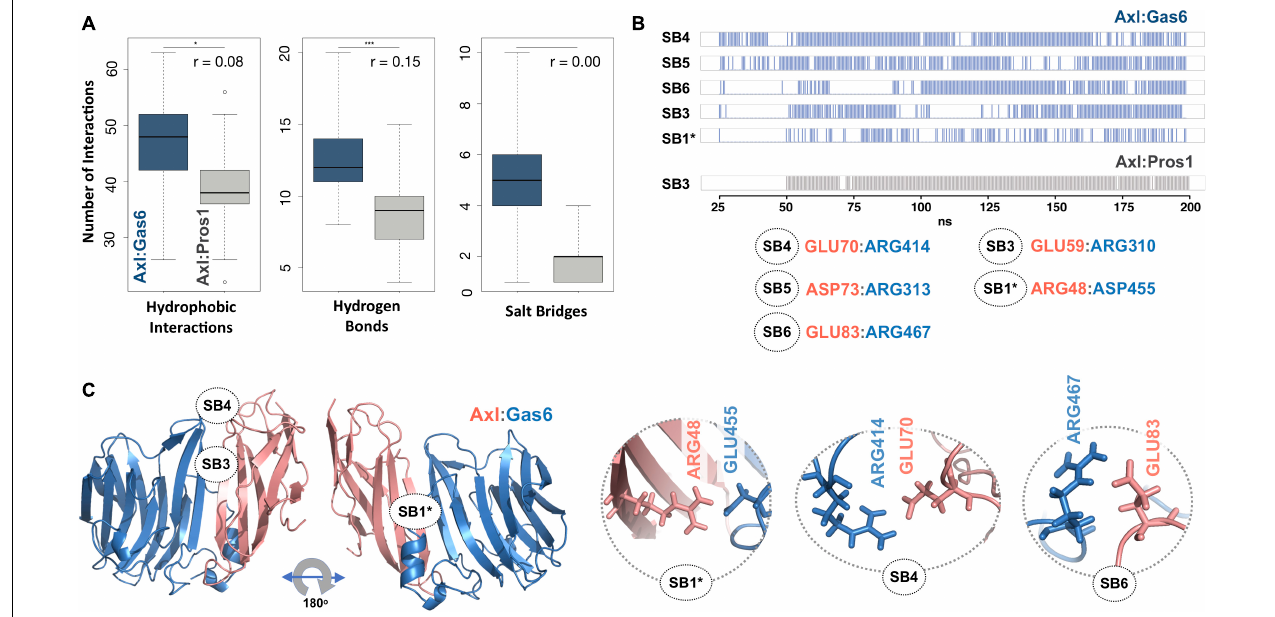
FIGURE 3 | (A) The distributions of hydrophobic contact (left), hydrogen bond (middle) and SB numbers (right) for Axl:Gas6 (marine blue) and Axl:Pros1 (light gray) simulations. The distributions are interpreted with box-and-whisker statistics. The associations between two Axl:Gas6 and Axl:Pros1 distributions were reflected in r values, according to which the SB distributions do not have anything in common. (B) Consistently and stably observed SBs formed in Axl:Gas6 and Axl:Pros1 simulations. Each row indicates the observation frequency of the indicated SB. The frequency data came from replica 1 simulations ( Table 2 ). The SB numbering follows the ones used in Figure 2C . SB1 is denoted with * as in this case R48 couples with a different Gas6 residue than observed in Figure 2C . (C) The positioning of potential SDPs on Axl:Gas6 structure predicted by molecular dynamics